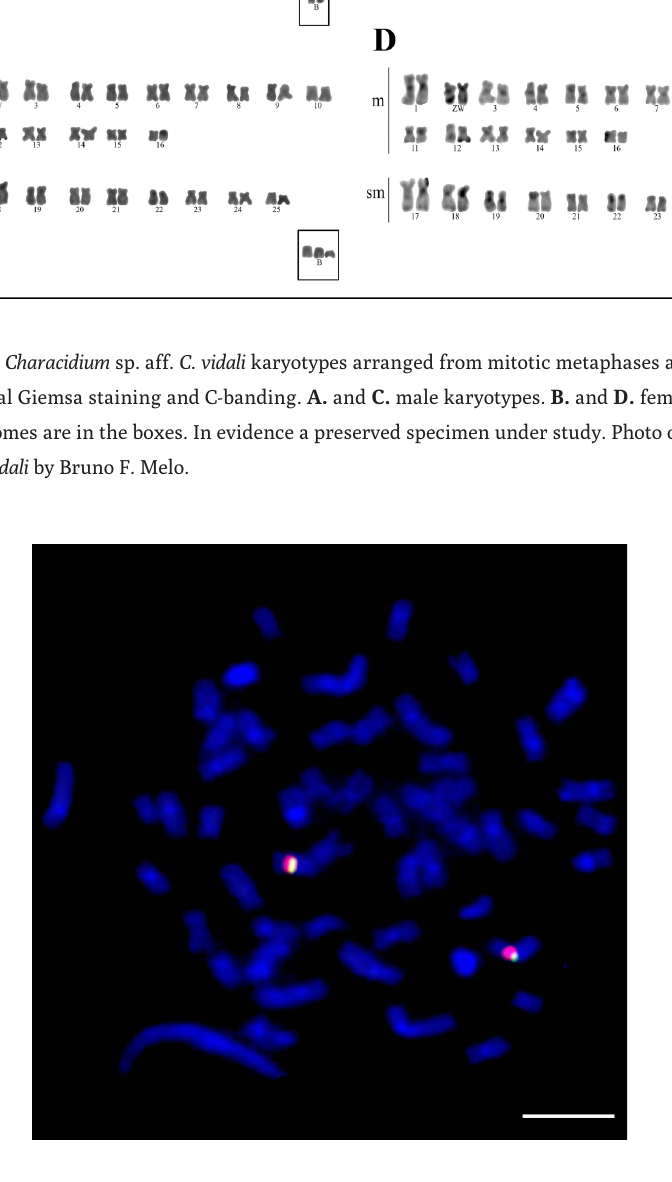
FIGURE 2 | Metaphase of Characidium sp. aff. C . vidali after FISH with histone H3 (green) and H4 (red) probe. Synteny marked in par 10. Scale bar = 10